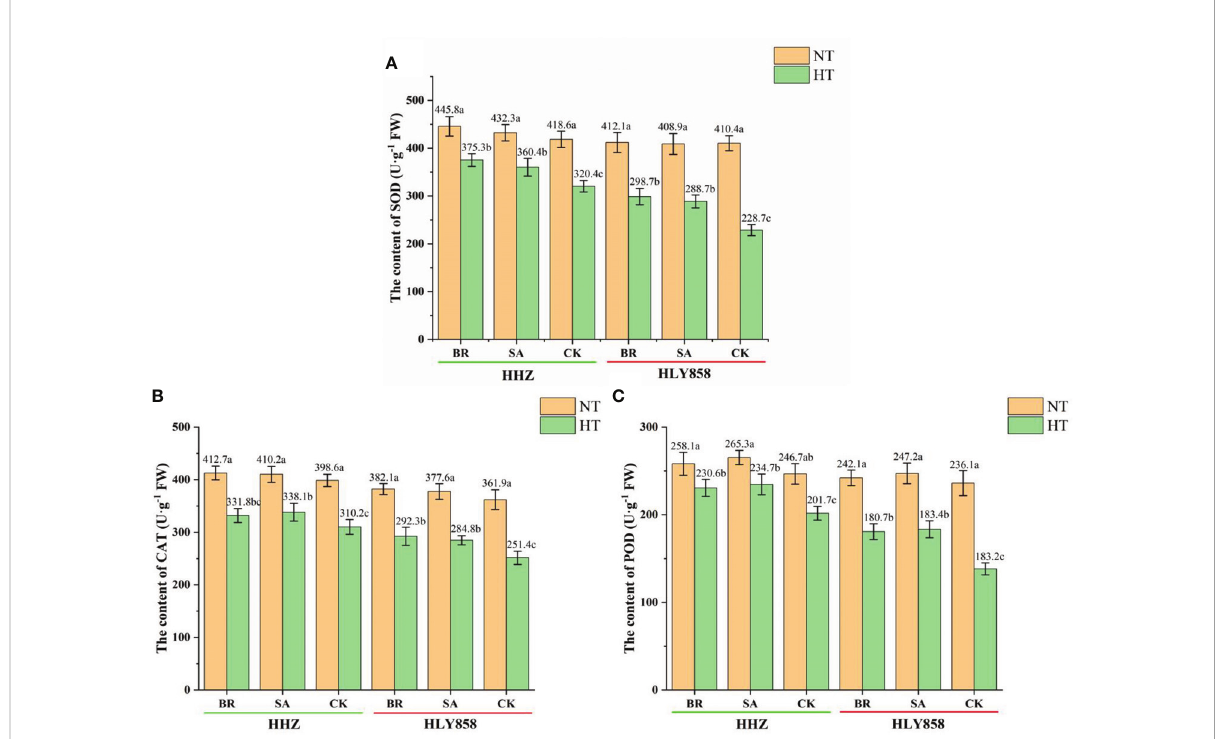
FIGURE 6 Effects of plant growth regulators on alleviating high temperature stress on antioxidant enzymes in the spikelet of two rice cultivars. (A) Superoxide dismutase (SOD); (B) catalase (CAT); (C) peroxidase (POD). Bars with different lowercase letters indicate a signi fi cant difference (LSD test, p < 0.05). Error bars indicate the SD of three biological replicates. HHZ, Huanghuazhan; HLY858, Huiliangyou 858; HT, high temperature; NT, normal temperature; BR, brassinolide; SA, salicylic acid; ABA, abscisic acid; 6-BA, 6-benzylaminopurine; MP, potassium dihydrogen phosphate; CK,